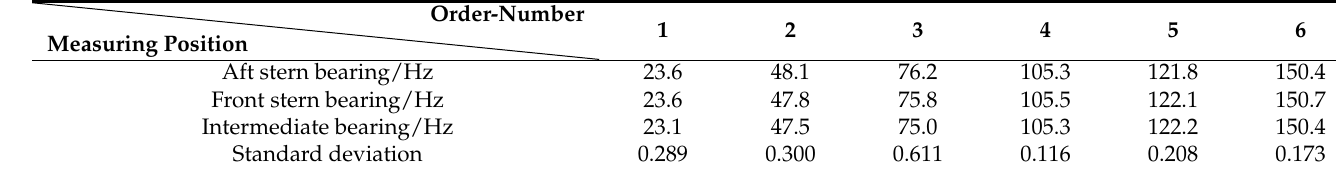
Figure 11. PDF of periodic frequency: ( A ) 22.7 Hz; ( B ) 22.9 Hz; ( C ) 23.6 Hz; ( D ) 24.6 Hz. Table 4. Natural frequencies of running propulsion shafting in the linear alignment